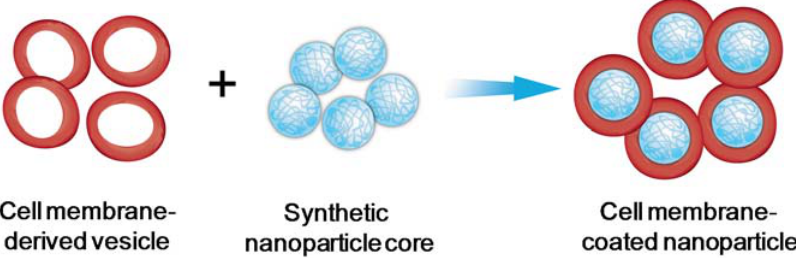
Figure 1. Schematic preparation of cell membrane-coated nanoparticles. Briefly, cell membrane-derived vesicles along with the associated membrane antigens are collected from source cells and then coated onto the surface of pre-formed synthetic